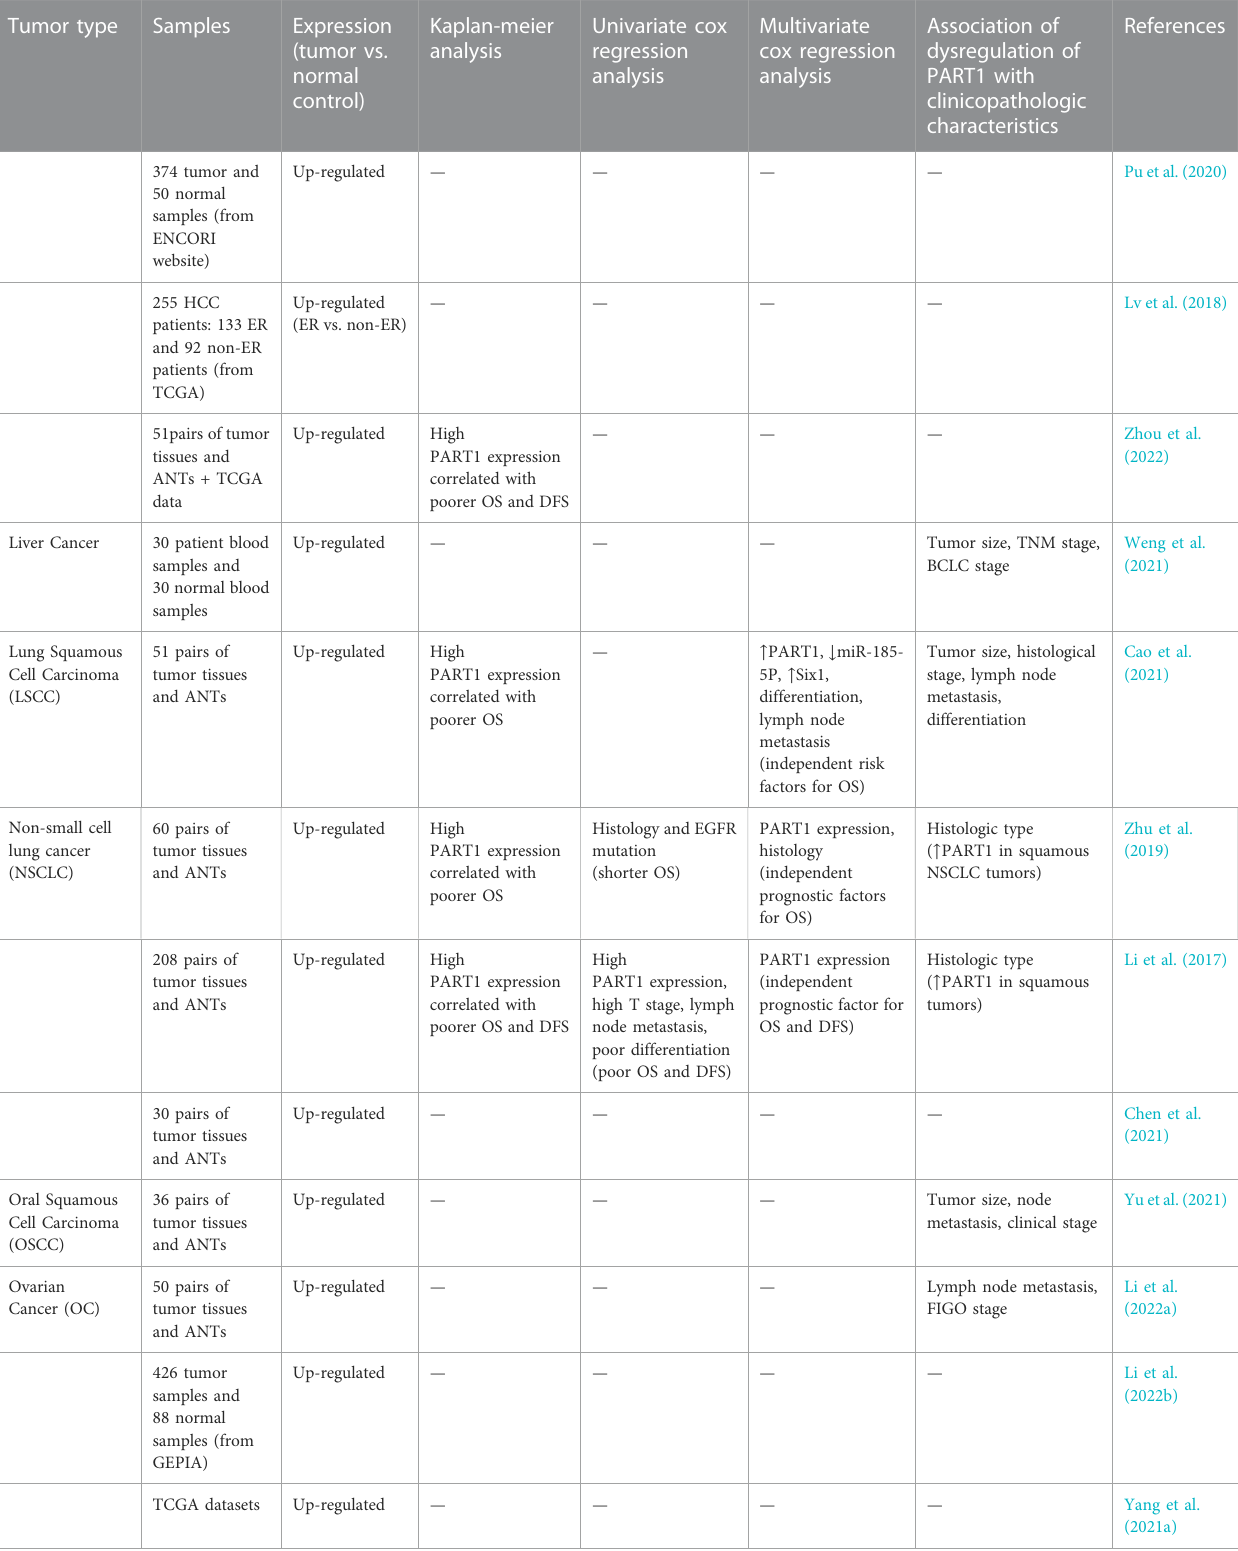
TABLE4( Continued )FunctionofPART1up-regulationinthedevelopmentofmalignancyonthebasisofstudiesinclinicalsamples(ANTs:adjacentnormaltissues, TCGA: thecancergenome atlas, METABRIC: moleculartaxonomy ofbreastcancerinternational consortium, GEPIA:gene expressionpro fi ling interactive analysis, GEO: gene expression omnibus, GTEx: genotype – tissue expression, ENCORI: encyclopedia of RNA interaction, GBM: high-grade glioma, LGG: low-grade glioma, ER: early recurrence, BCLC: Barcelona clinic liver cancer, OS: overall survival, DFS: disease-free survival, FIGO: international federation of gynecology and obstetrics, TNM: tumor-node-metastasis, T stage: tumor stage, T classi fi cation: tumor classi fi